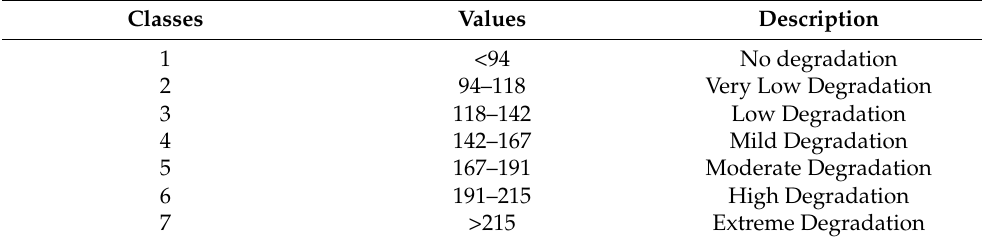
Table 4. WLDI scaled values of degradation degree [74].